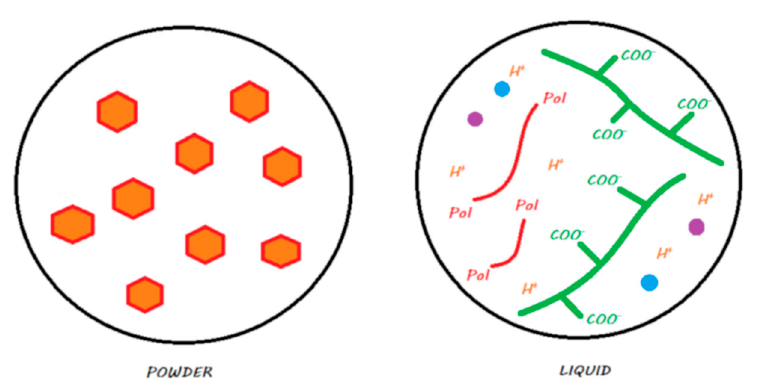
Figure 6. An RM-GIC in its storage medium. The powder, in contrast with GICs and HV-GICs, contains silanated FAS fillers; the liquid contains the same components as those in the GIC liquid but with HEMA monomers added to the formulation.